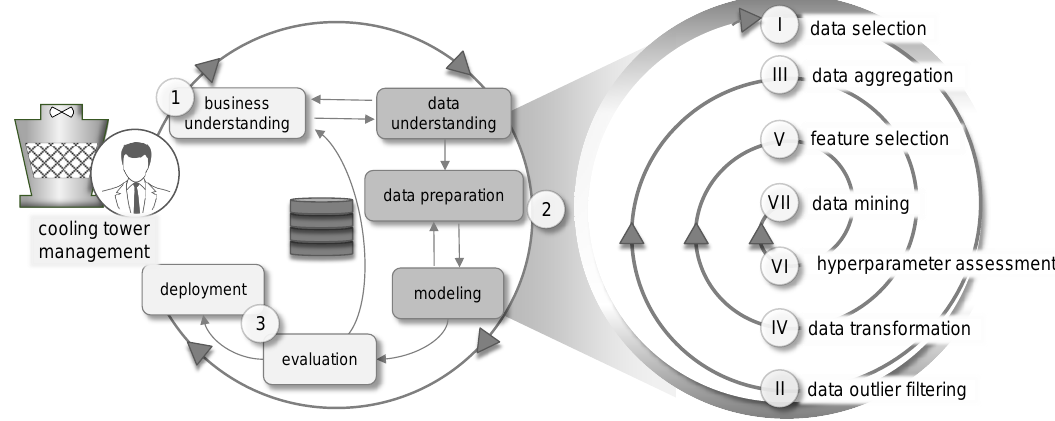
Figure 3. Workflow to create a data-driven digital twin.